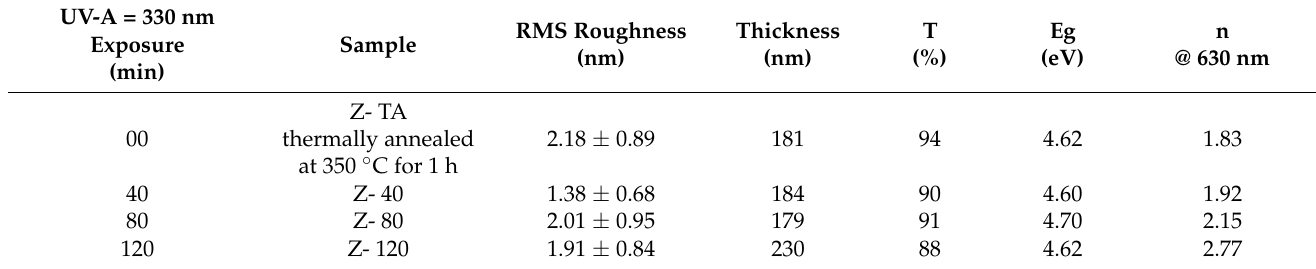
Table 1. Physical and optical parameters obtained for thermally treated and UV-A treated ZrO 2 thin films. UV-A = 330 nm Exposure